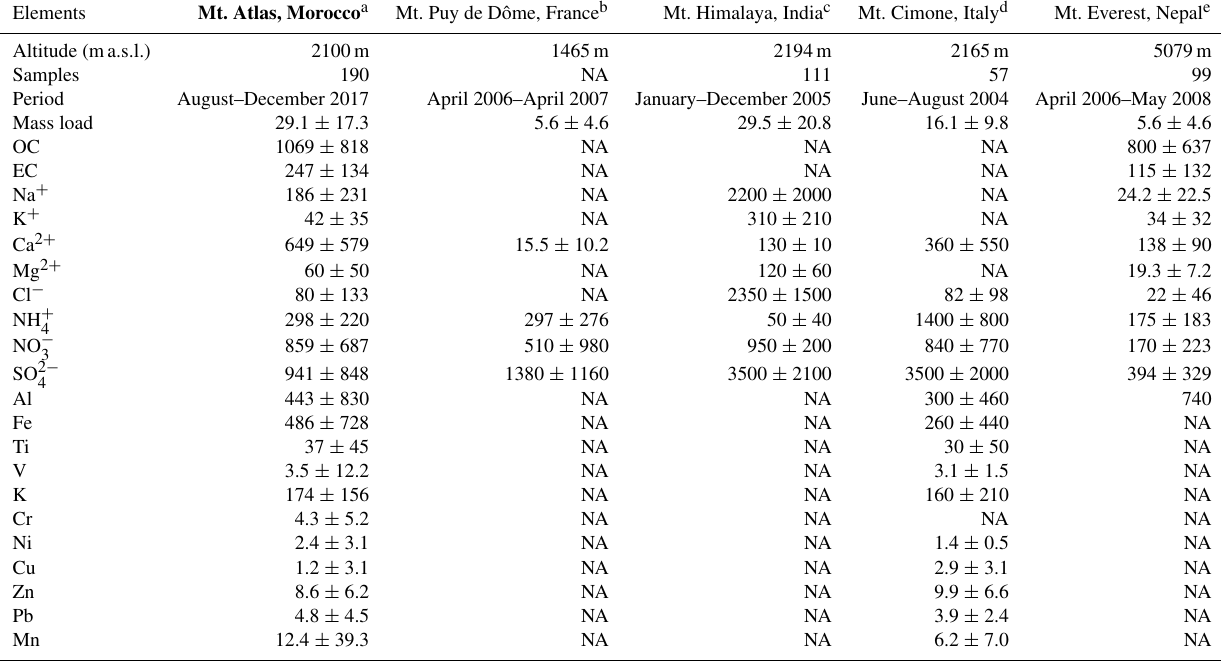
Table 5. Concentrations of main aerosol chemical species in PM 10 (ngm − 3 ) at AMV compared to other high-altitude mountain stations. Data are reported in the format average (mean ± standard deviation). NA: not available. Note that the concentrations of PM 10 mass are given in micrograms per cubic meter (µgm − 3 ).